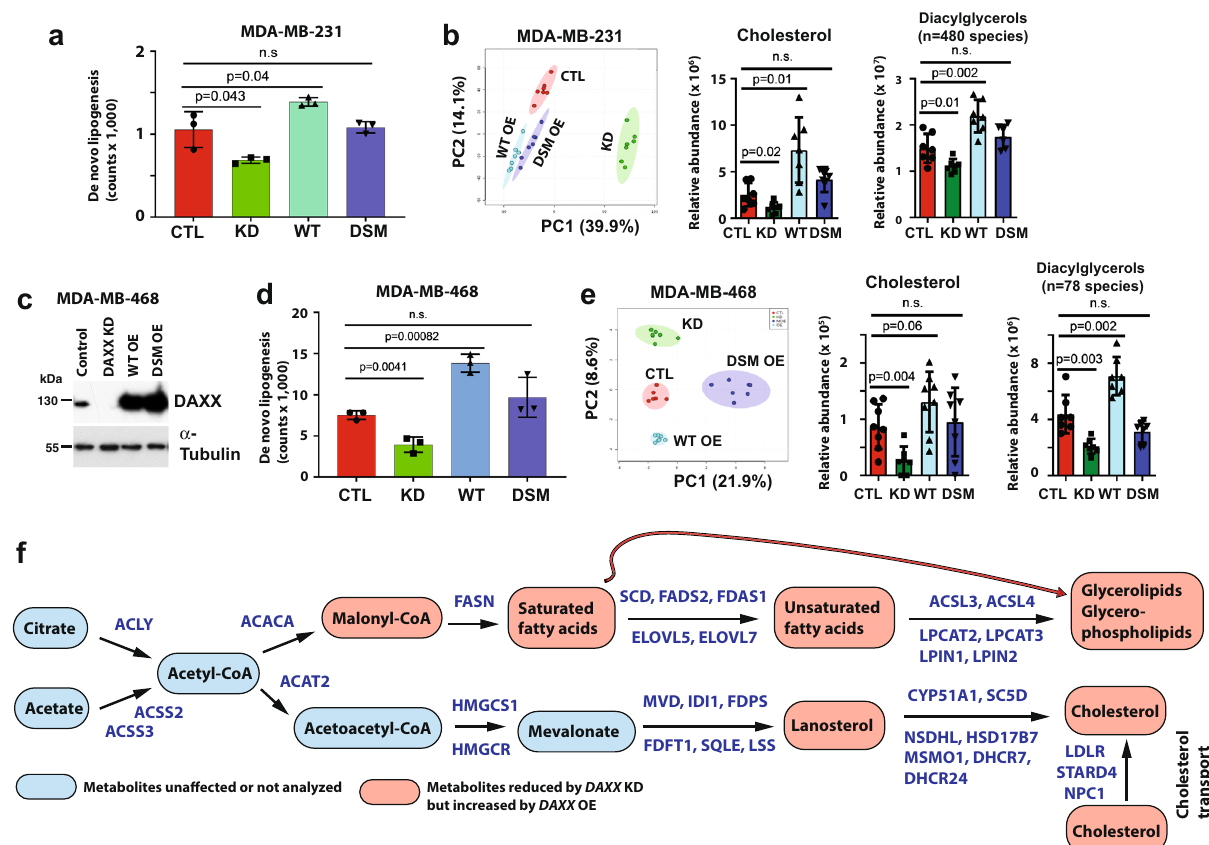
Fig. 3 | DAXX promotes lipid production. a , d Impact of DAXX expression levels on acetate-dependent de novo lipid synthesis using [ 14 C]-acetate labeling in the absence of serum in cell lines derived from MDA-MB-231 ( a ) and MDA-MB-468 ( d ) ( n =3 biologically independent samples). b , e Principal component analysis (PCA) of lipidome in the panel of four MDA-MB-231 and MDA-MB-468-derived cell lines (CTL, KD, WT OE, and DSM OE). Levels of cholesterol and diacylglycerols as detected by LC/MS in the indicated cell lines are shown. n refers to the number of lipidmoleculesintheindicatedlipidclasses. c ValidationofshRNA-mediated DAXX